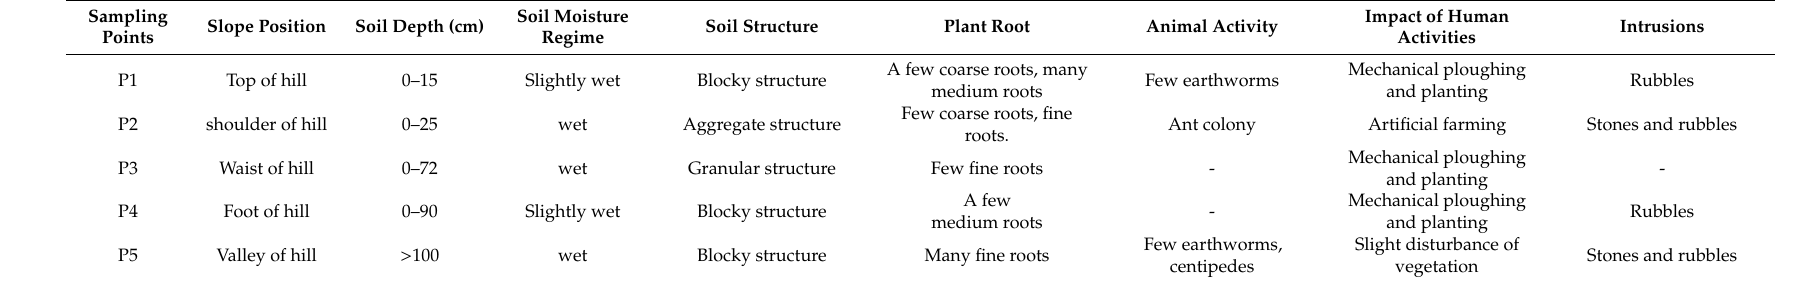
Table A1. The importation of soils at di ff erent sample